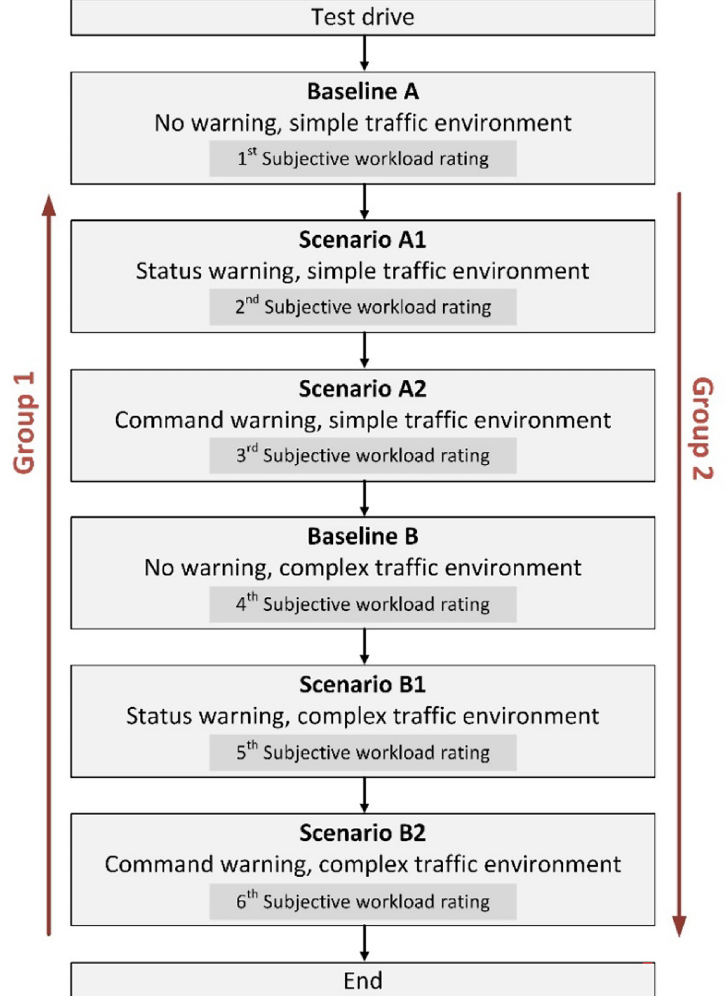
Figure 6 Counterbalanced experiment procedure for the two